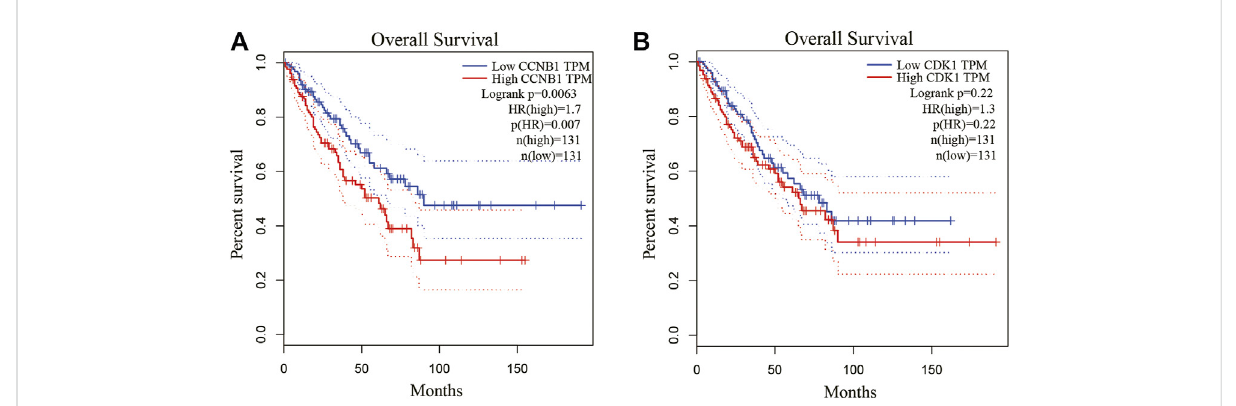
FIGURE 7 Kaplan-Meiersurvivalcurvesofhubgenes. (A) Kaplan-MeiersurvivalcurvesofCCNB1andCDK1. (B) Thesurvivalprognosisofthepatientsinthe high-expression group was signi fi cantly worse than that of the patients in the low-expression group ( p < 0.05).